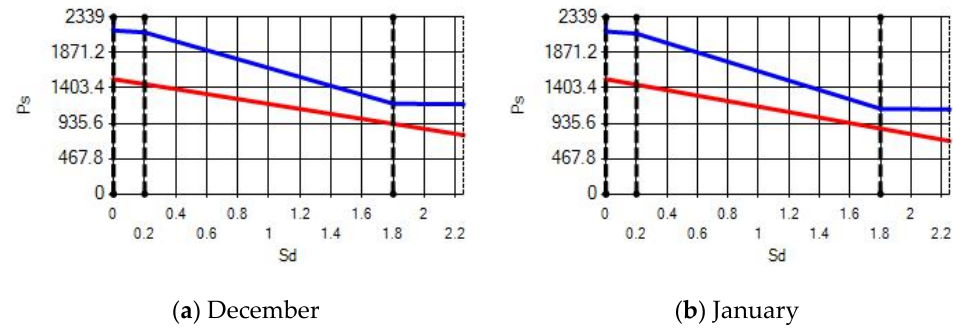
Figure 14. Condensation and evaporation amount chart for the building elements of the AAC external wall for the 1st zone for ( a ) December and ( b ) January.